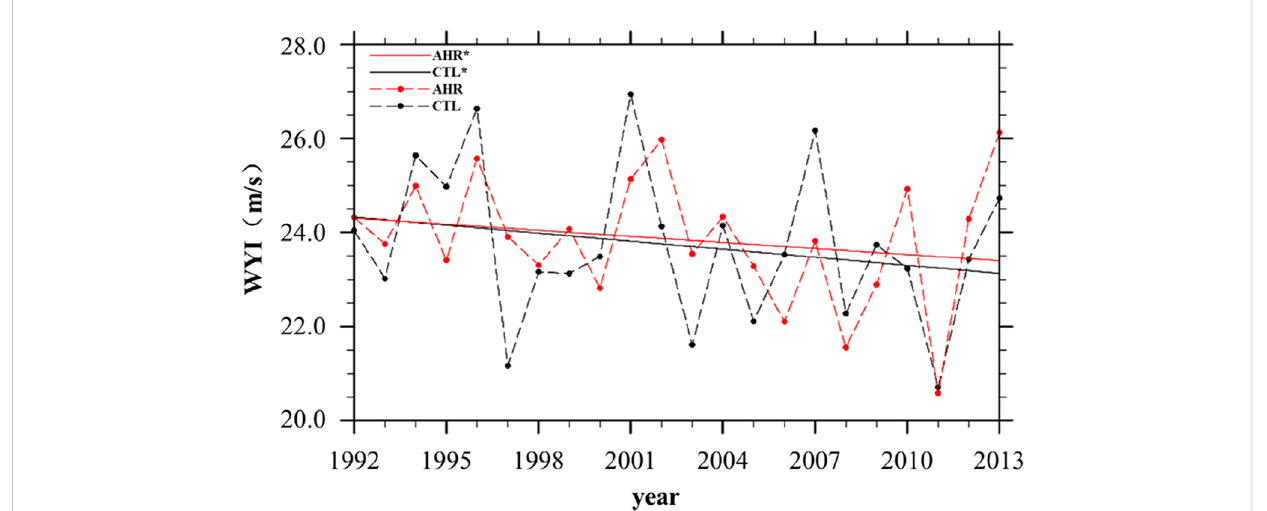
FIGURE 9 The Webster – Yang index (WYI) (unit: m s − 1 ) changes from 1992 to 2013 in the boreal summer (JJA): the dashed line in black: CESM1 control modeling results (CTL) without AHR, the solid lines in black (CTL*) is the linear fi tting results for control modeling results without AHR; the dashed line in red: CESM1 modeling results considering AHR (AHR), the solid lines in red (AHR*) is the linear fi tting results for modeling results considering AHR.